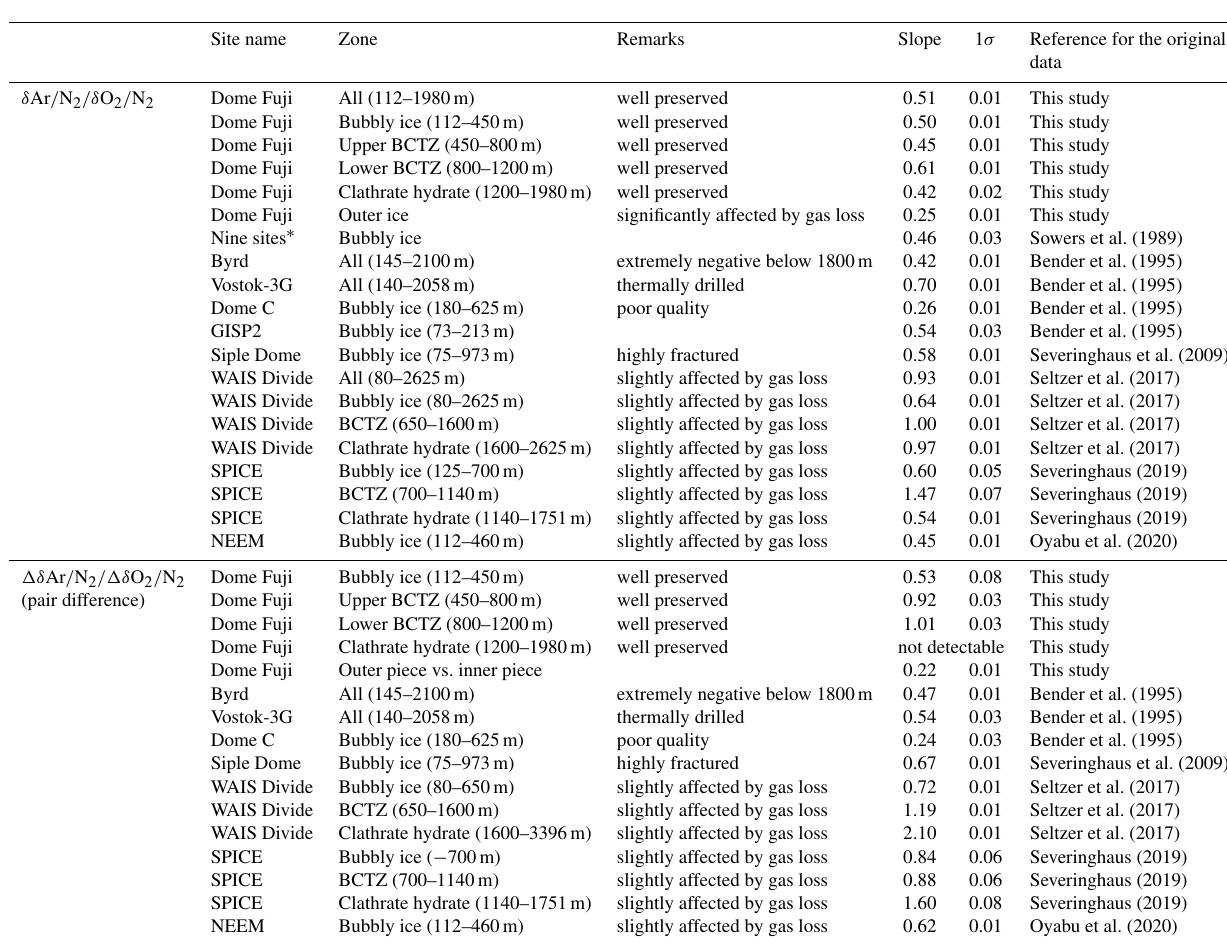
Table C2. Slopes for δ Ar / N 2gravcorr vs. δ O 2 / N 2gravcorr and for (cid:49)δ Ar / N 2gravcorr vs. (cid:49)δ O 2 / N 2gravcorr